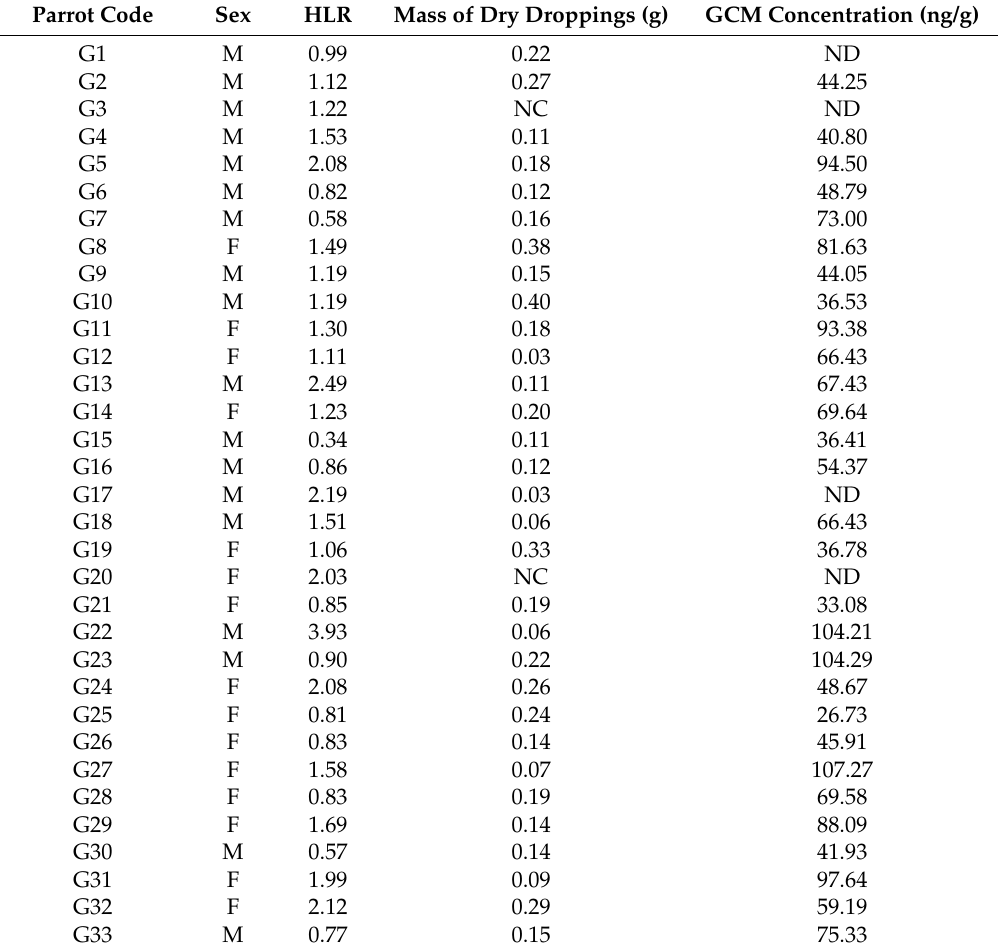
Table 7. Sex, Heterophil: Lymphocyte Ratio (HLR), and individual droppings’ data of the African Grey Parrot studied